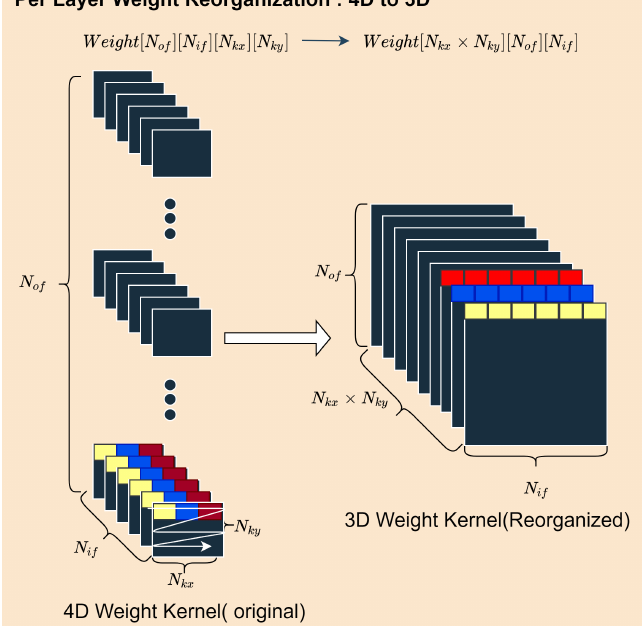
Figure 8. Weight 4D–3D reorganization. The colors are only to show a sample of the corresponding pixels’ positions before and after the reorganization of the weight